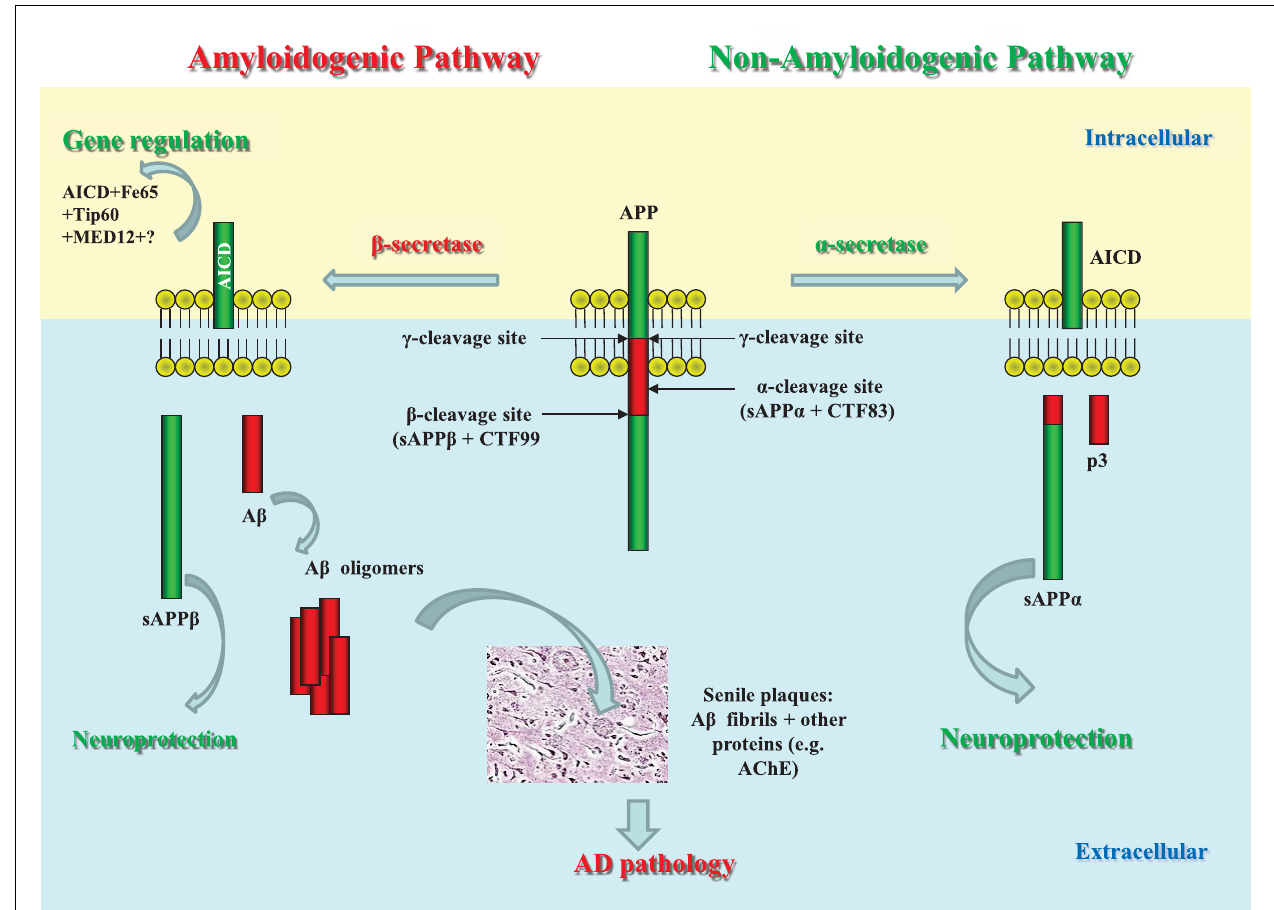
cleaved at the α -secretase site within the A β -domain releasing a soluble ectodomain sAPP α and the C-terminal fragment CTF83. Proteolytic cleavage of CTF83 by γ -secretase releases AICD and p3 fragment whose functions are still unknown.The AICD fragment produced in the amyloidogenic pathway binds to a stabilizing factor Fe65 and in a complex with other factors (the histone acetyl transferase,Tip60, and a Mediator complex subunit Med12) can act as transcription factor regulating expression of a variety of genes, including an A β -degrading enzyme neprilysin.This process was found to be specific to the neuronal APP 695 isoform. AICD produced in the non-amyloidogenic pathway and from other APP isoforms (APP 751 and APP 770 ) is most likely to be degraded (e.g., by some intracellular proteases, e.g., insulin-degrading enzyme). Soluble APP ectodomains, sAPP α , and sAPP β , have been shown to have neuroprotective